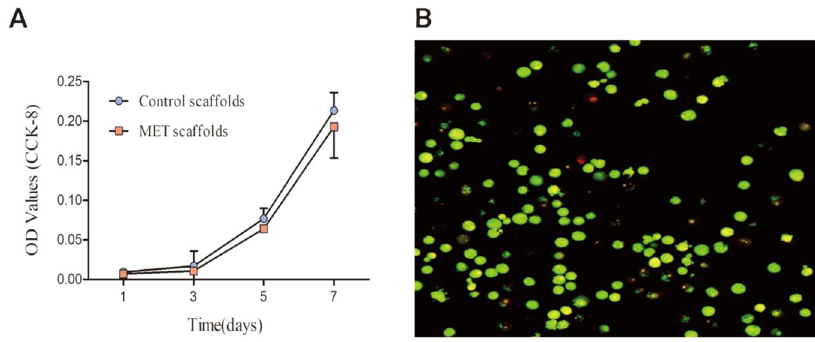
Fig. 4 A The proliferation of BMSCs attached on scaffolds was con fi rmed by CCK-8